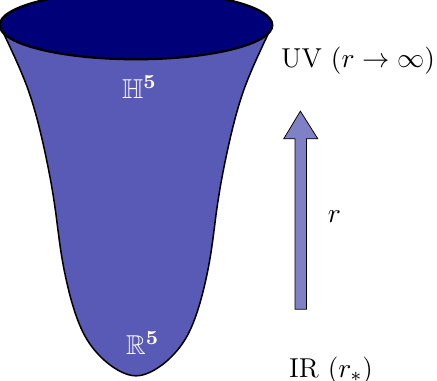
Figure 1. The regular five-dimensional geometries interpolate between AdS 5 in the UV and R 5 in the IR.